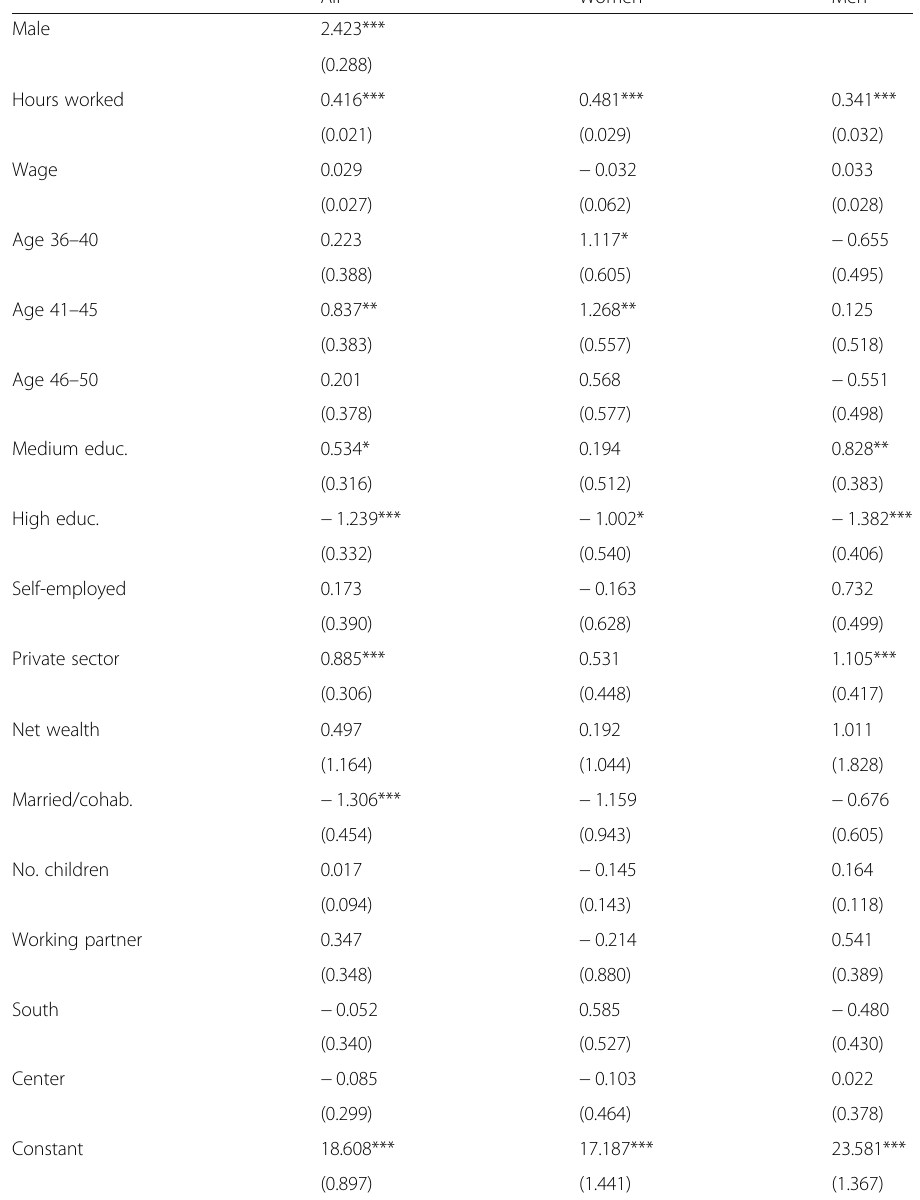
Table 7 Desired working hours, workers aged 31 –